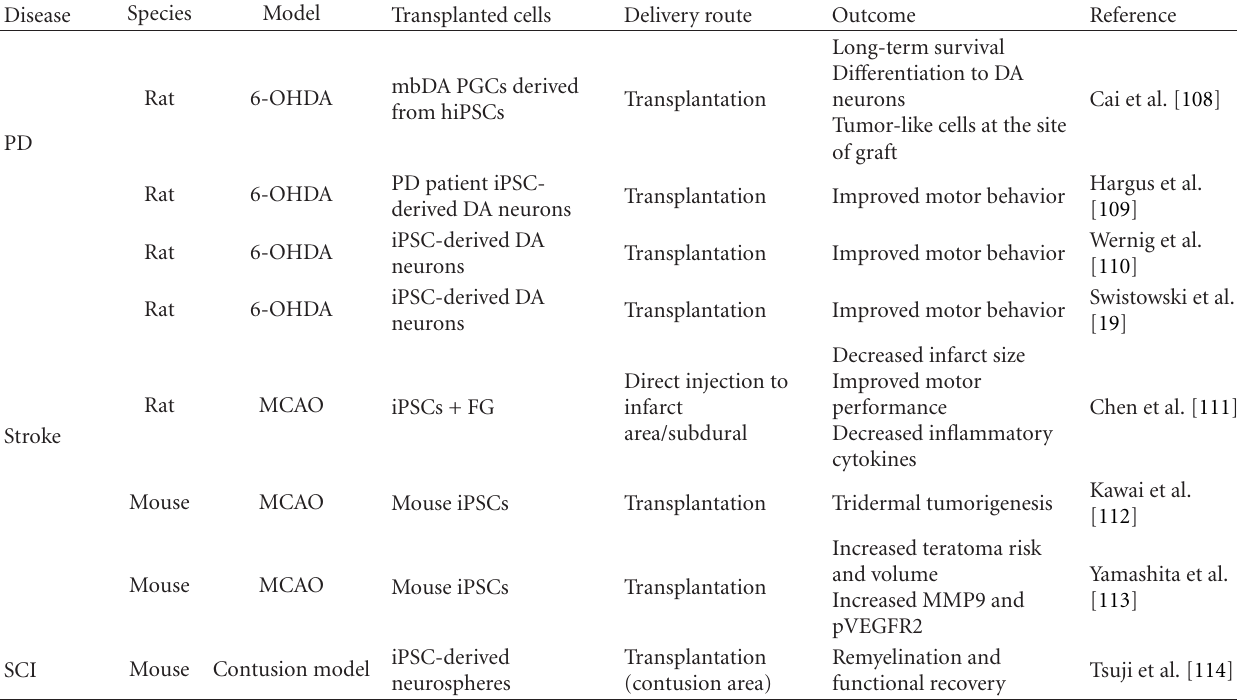
Table 2: iPSC-based cell-replacement therapy in preclinical animal models of neurological diseases.